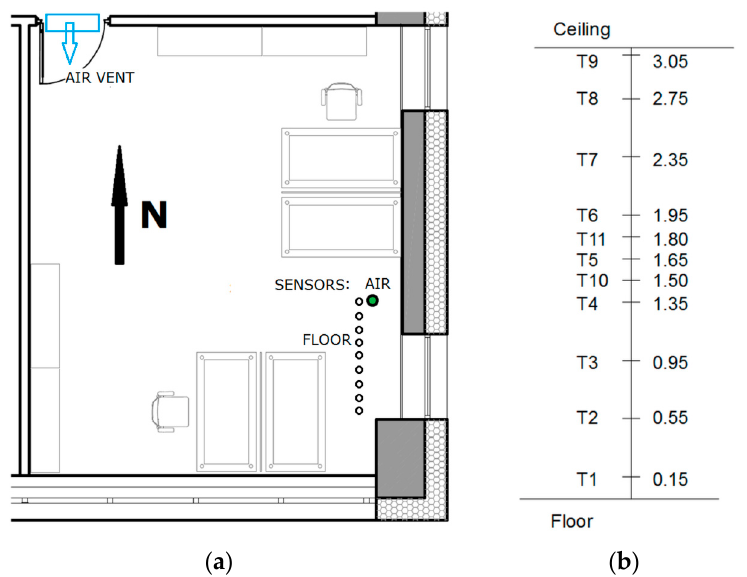
Figure 4. ( a ) Layout of the room; ( b ) layout of the temperature sensors. On the right—height above the floor (in meters).